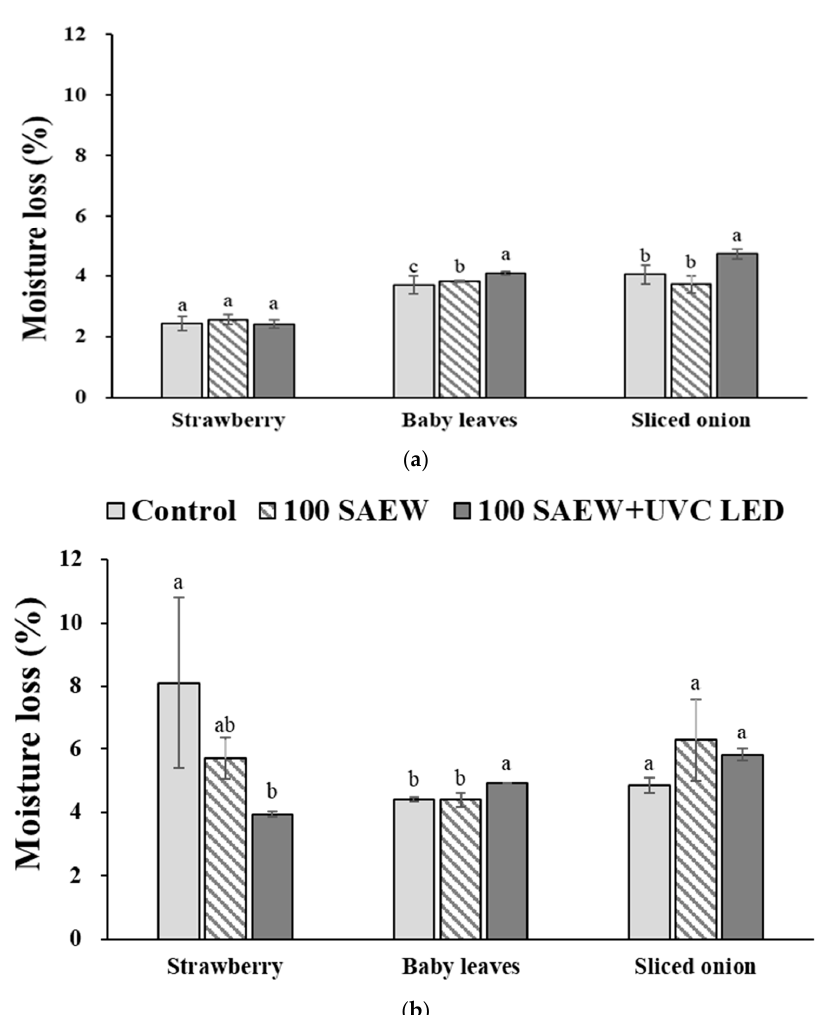
Figure 4. Moisture loss of strawberry, baby leaves, and sliced onion during storage at ( a ) 10 and ( b ) 15 °C for 7 days after applying to inactivate treatment. Control, no extra wash with a sanitizer; 100 SAEW, aerosolization with 100 ppm SAEW; 100 SAEW + UVC LED, aerosolization with 100 ppm SAEW and UVC LED radiation (275 nm). a–c Different letters represent significant differences measured by Duncan’s multiple tests among treatments within each soft fresh produce at p <